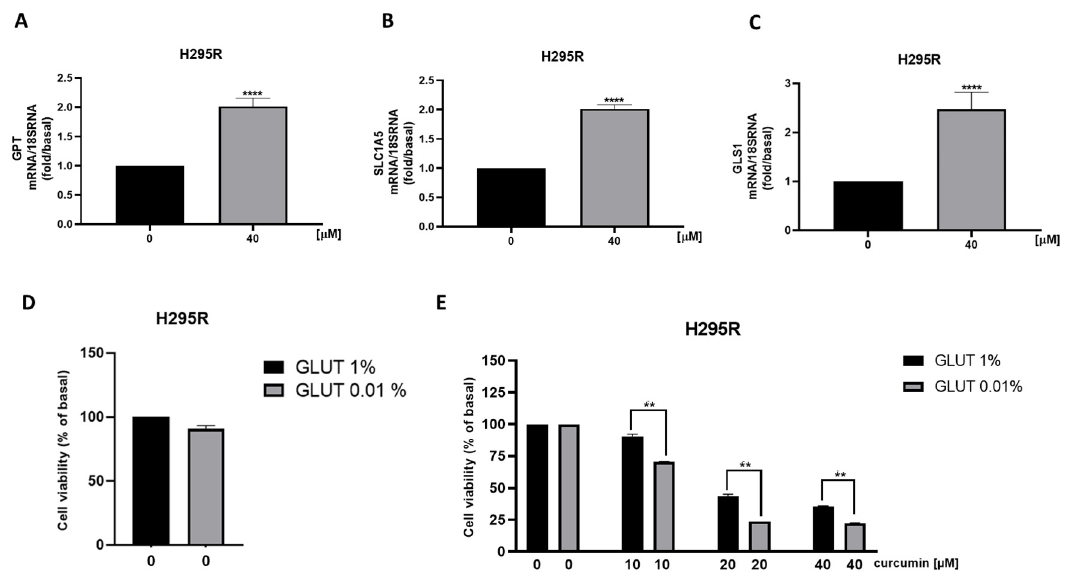
Figure 11. Limiting glutamine availability potentiates curcumin anti tumoral effects. ( A – C ) Real-time RT-PCR for GPT, SLC1A5, GLS1 gene expression in H295R cells treated for 24h with curcumin (40 µ M) in the presence of low (0.01%) glutamine (GLUT) concentration. Data represent the mean ± SE of values from at least three independent RNA samples (** p < 0.01). ( D , E ) H295R cells were treated with increasing doses (0, 10, 20, 40 µ M) of curcumin for 48h in the presence of default (1%) and low (0.01%) glutamine concentration. Cell viability was evaluated by MTT assay. Results are expressed as mean ± SE of three independent experiments (**** p < 0.01 vs. 0 µ M; ** p < 0.01).